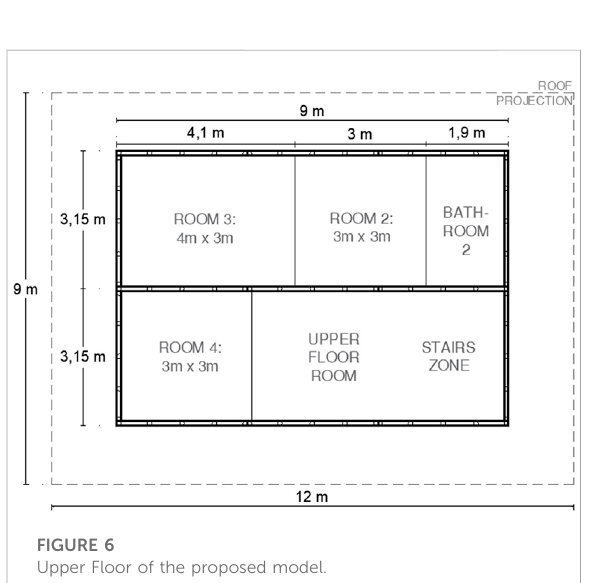
FIGURE 6 Upper Floor of the proposed